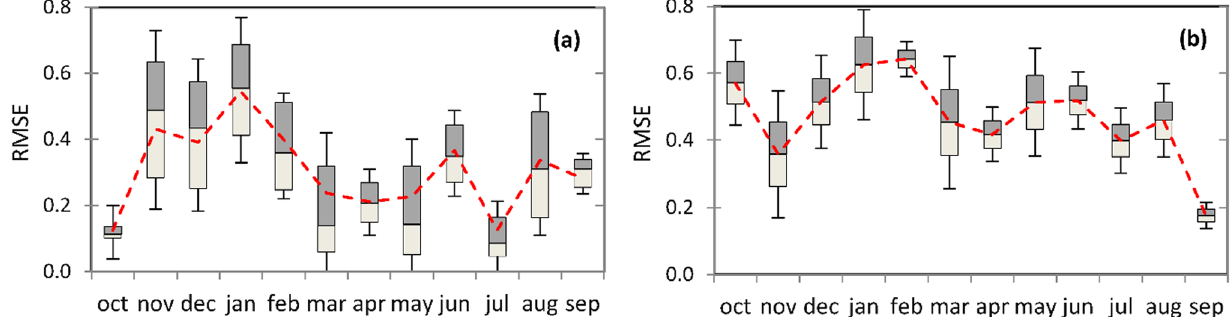
Fig.5 Values of mean absolute error for GWL in MODFLOW model in transient state during period a calibration b